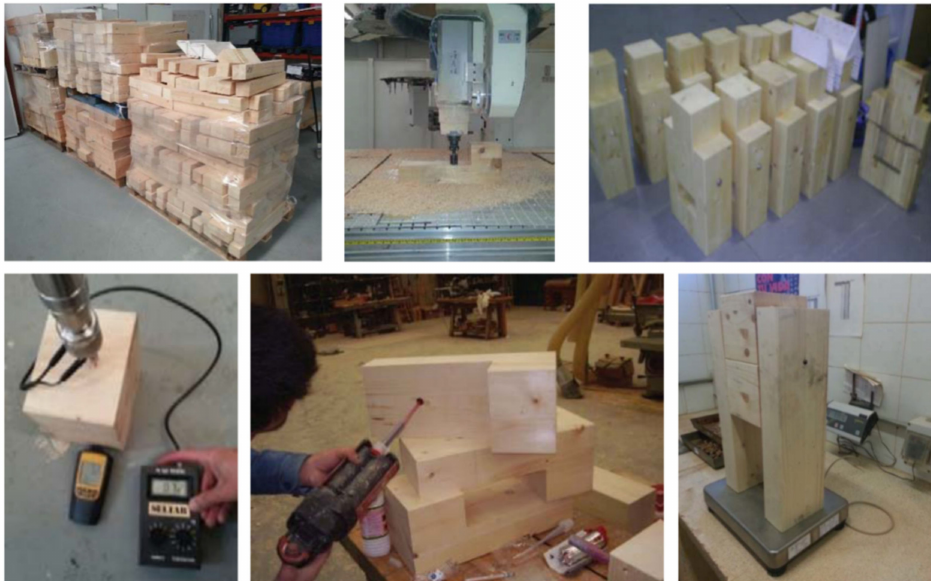
Figure 2. Reception, manufacture, test samples, moisture measurement and conditioning the hole for dowel insertion and weight measurement.